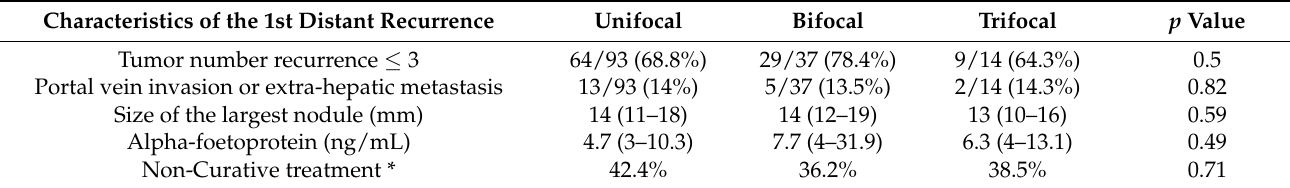
Figure 2. Time-to-distant-recurrence according to the number of HCC nodule (s). Table 3. Characteristics of the first distant